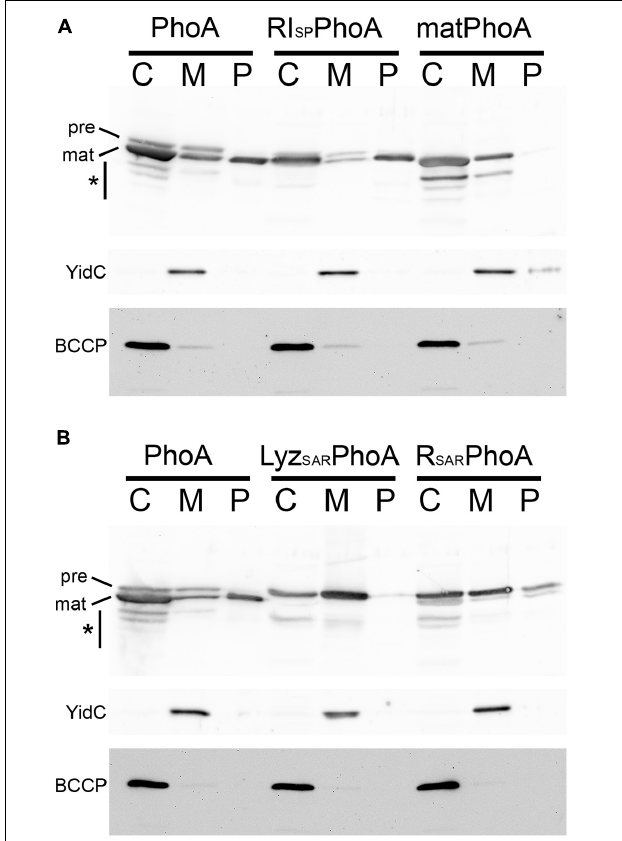
FIGURE 2 | The RI signal peptide can mediate the transport of alkaline phosphatase PhoA into the periplasm. (A) Detection of PhoA in subcellular fractions of strains producing either full-length PhoA (PhoA), a RI signal peptide fusion with the mature domain of PhoA (RI SP PhoA), or signal peptide-deficient mature PhoA (matPhoA), using SDS-PAGE/Western blotting. (B) SDS-PAGE/Western blotting detection of PhoA and the PhoA fusions to the SAR domains of endolysins Lyz (from phage P1) and R (from phage P21). Note that SAR domains of these pinholin-associated endolysins are not efficiently cleaved and the precursor becomes detectable in the periplasmic fraction. PhoA and its derivatives were detected by PhoA-specific polyclonal antibodies. Asterisks indicate regions with degradation bands. BCCP detection showed that no cytoplasm was leaking into the periplasmic fractions. The YidC control monitored potential contamination by cytoplasmic membranes. C, cytoplasmic fraction; M, membrane fraction; P, periplasmic fraction. Asterisks indicate regions with degradation